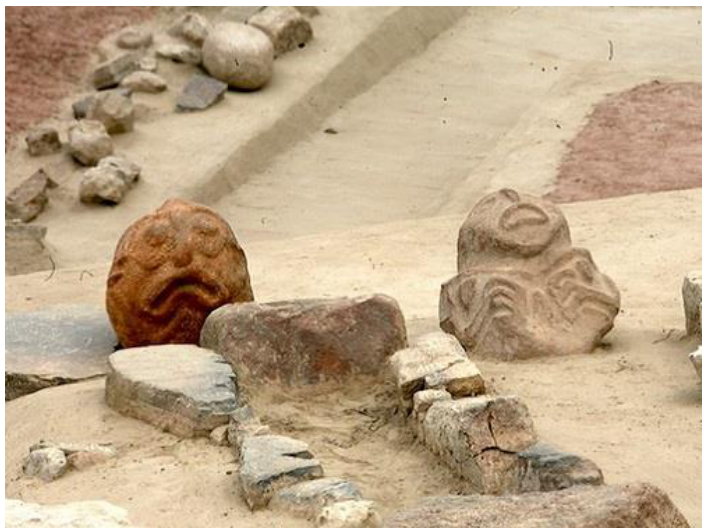
Figure 14. The front of the sanctuary dwelling No. XLIV (Lepenski Vir I) with sculptures of the Danube and a typical, iconic sculpture from Lepenski Vir [22]